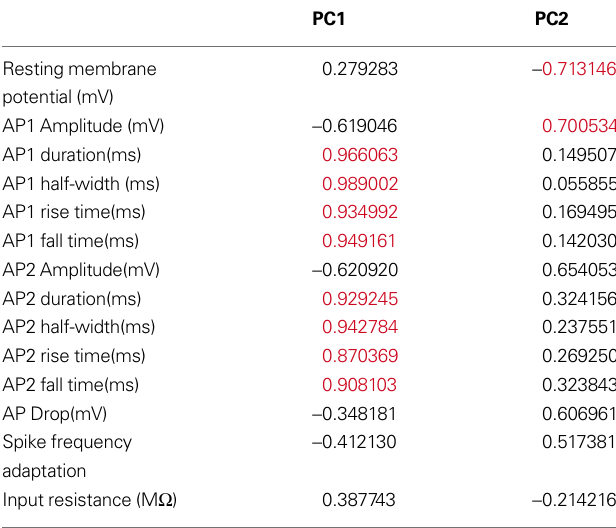
Table 7 | Correlations between electrophysiological variables and the fi rst 2 principal components of the 36-cells electrophysiology variables